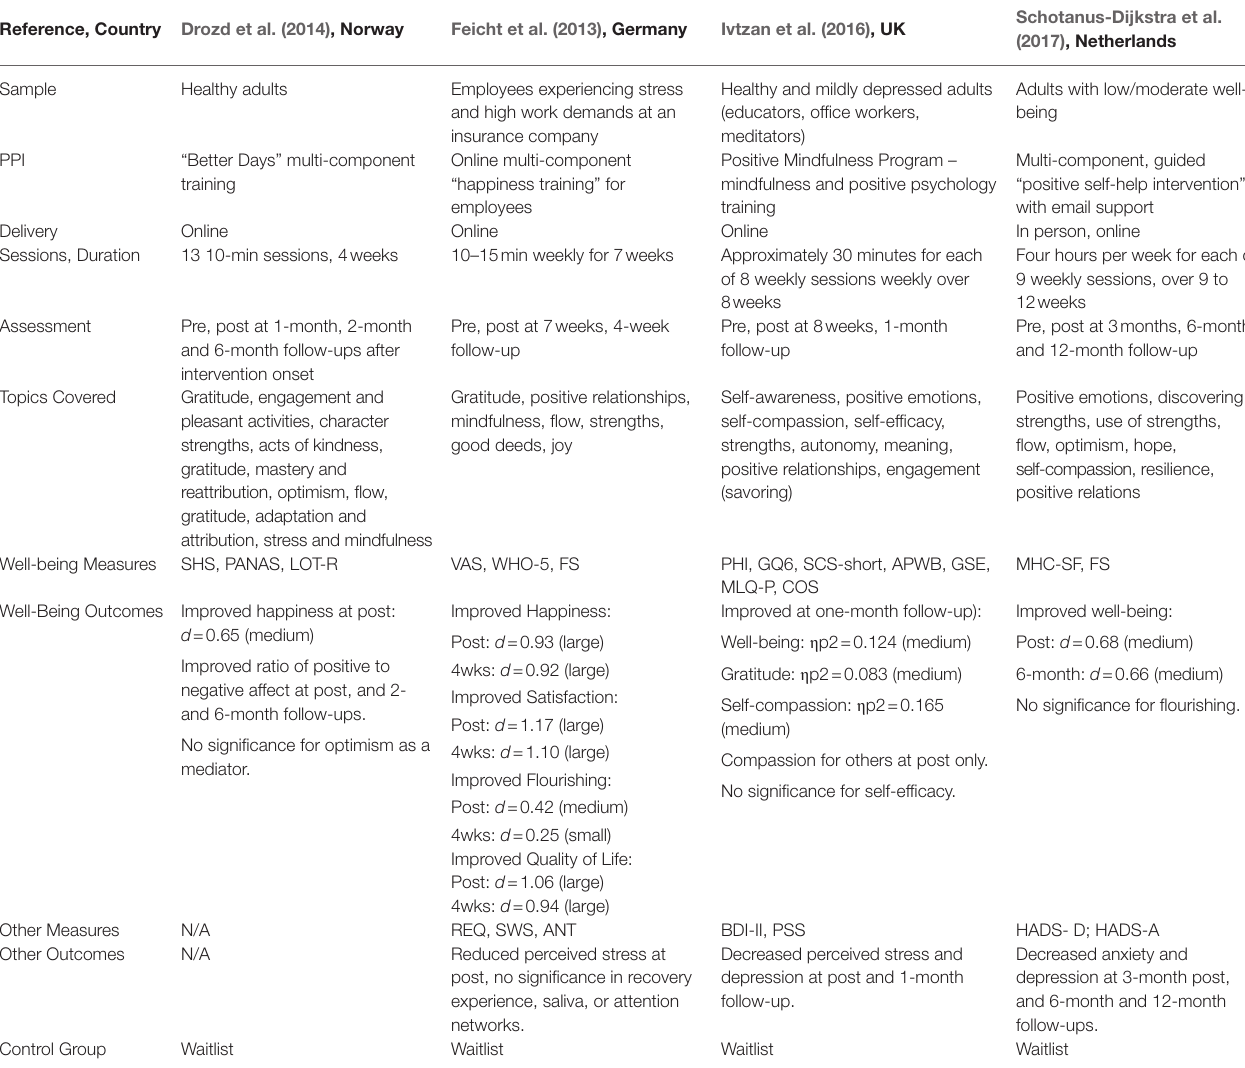
TABLE 3 | Promising PPIs for generating well-being in a global